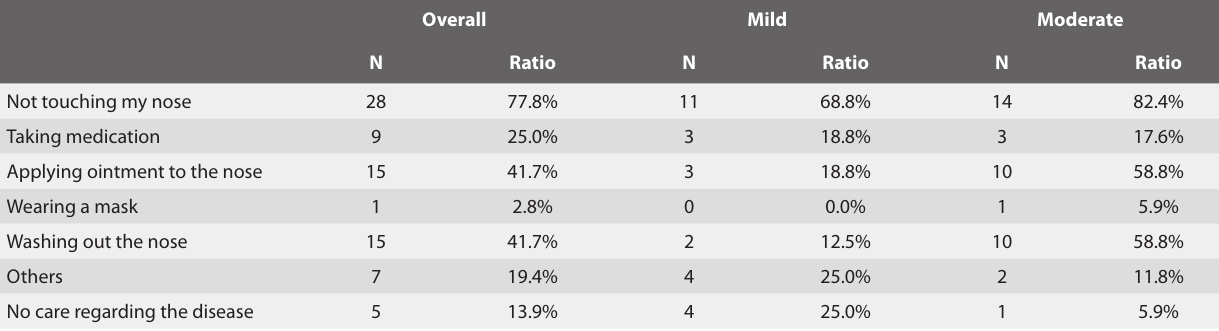
Table 4. Preventive measures to avoid epistaxis daily, as reported by the patients (multiple answers were